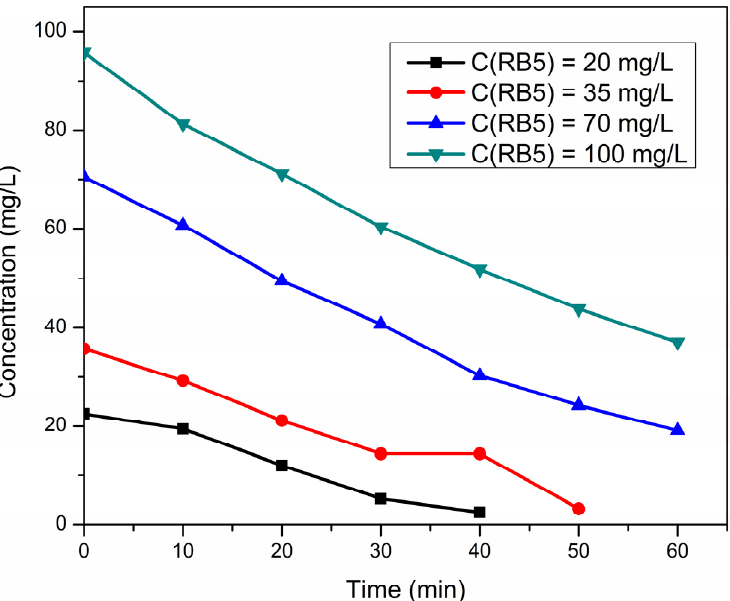
Figure 6. Degradation of RB5 dye under pH 2, 0.15 M Na 2 SO 4 , I = 0.17 A, and different initial concentrations of RB5 ranging from 20 mg/L to 100 mg/L.